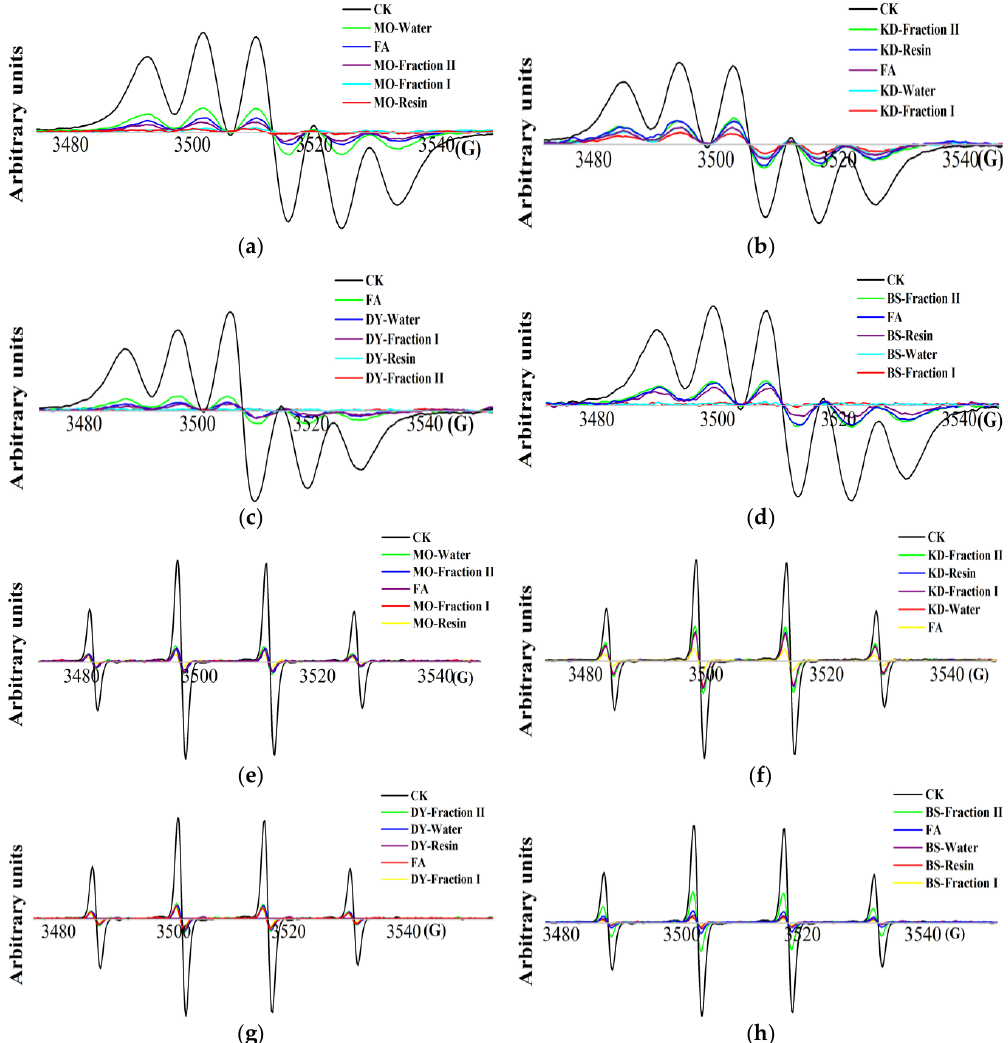
Figure 2. EPR spectra of DPPH · and HO · scavenging: ( a – d ) the EPR signal of DPPH · scavenging from four components of one of herbal teas and green teas; ( e – h ) the EPR signal of HO · from four components of one of herbal teas and green teas. The abscissa was represented by the G factor, which represents the strength of the magnetic field; the ordinate was expressed in arbitrary units, indicating the relative strength of the signal.